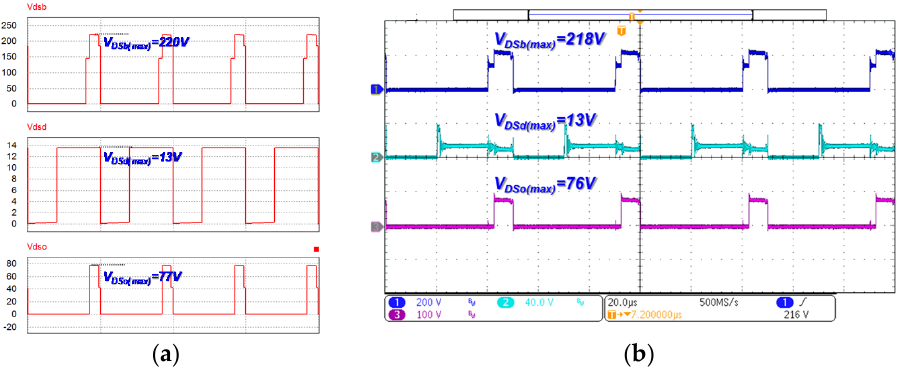
Figure 8. Switch voltage waveforms in the battery discharging mode: ( a ) by simulation; and ( b ) by measurement.